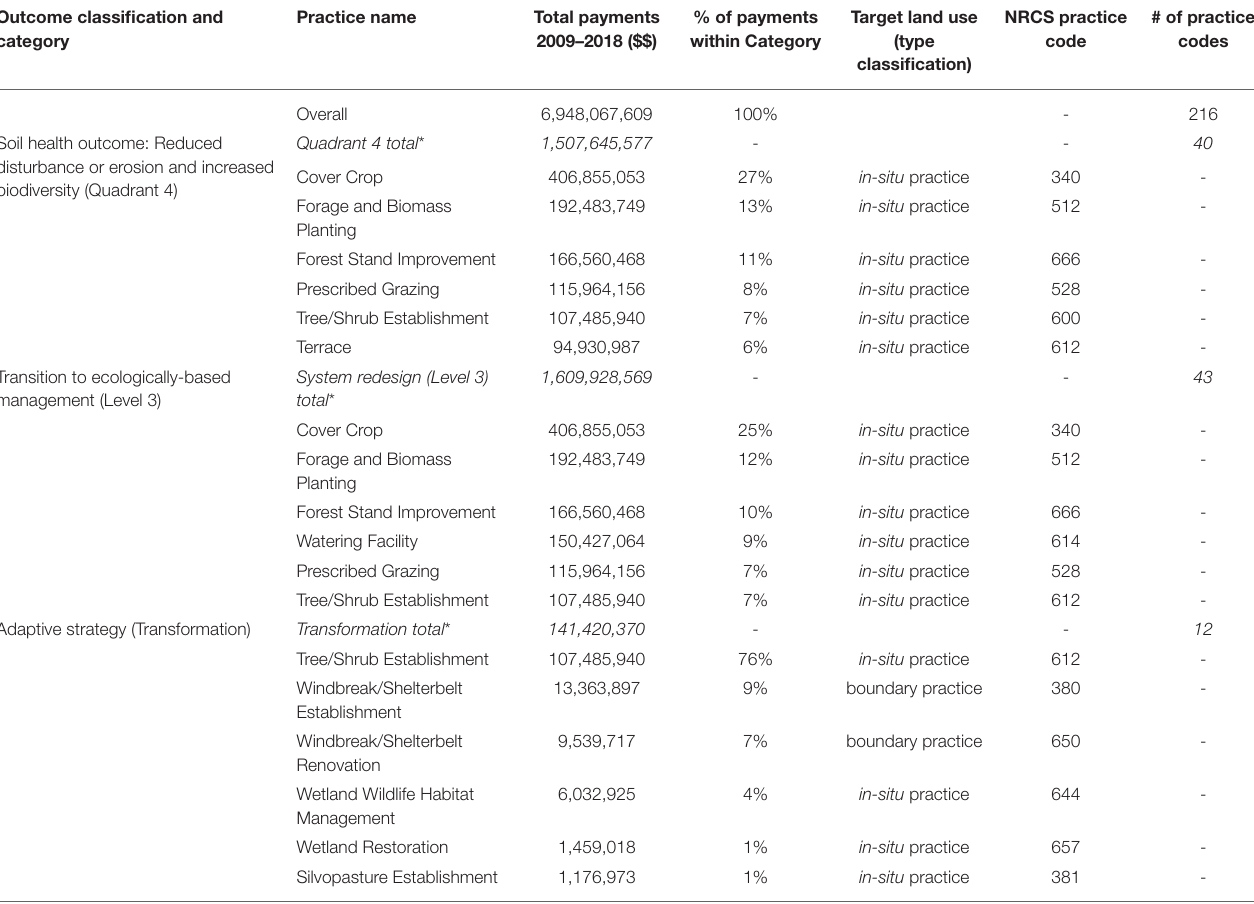
TABLE 3 | Practices that comprised 70–90% of funding dollars analyzed in the EQIP program from 2009 to 2018 within the categories considered in our analysis to have the greatest potential to improve environmental